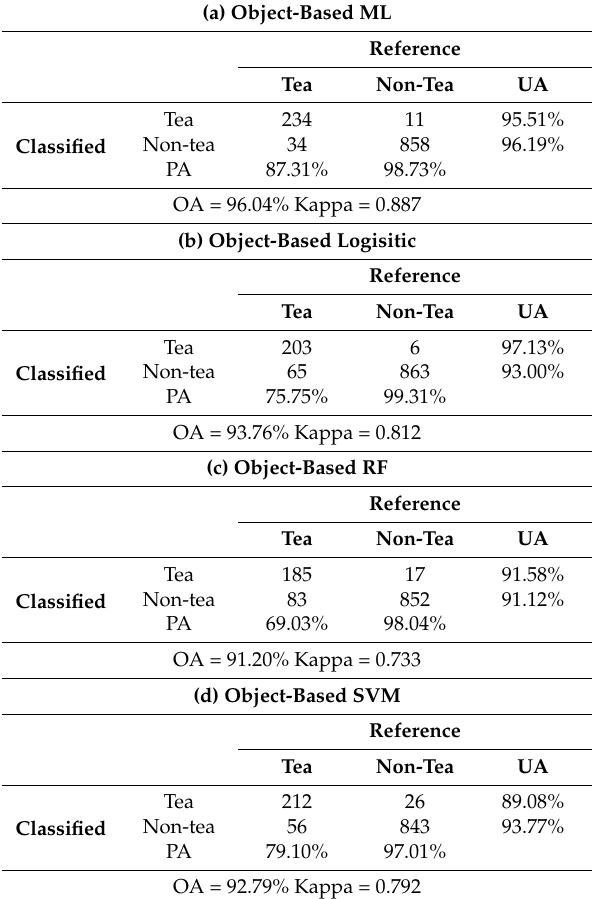
Table 6. Error matrix for object-based classification with six selected variables; the unit is object